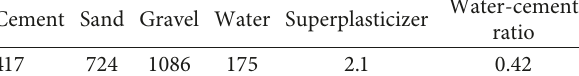
Table 1: Designed concrete mix proportions (kg/m 3 ) [37].